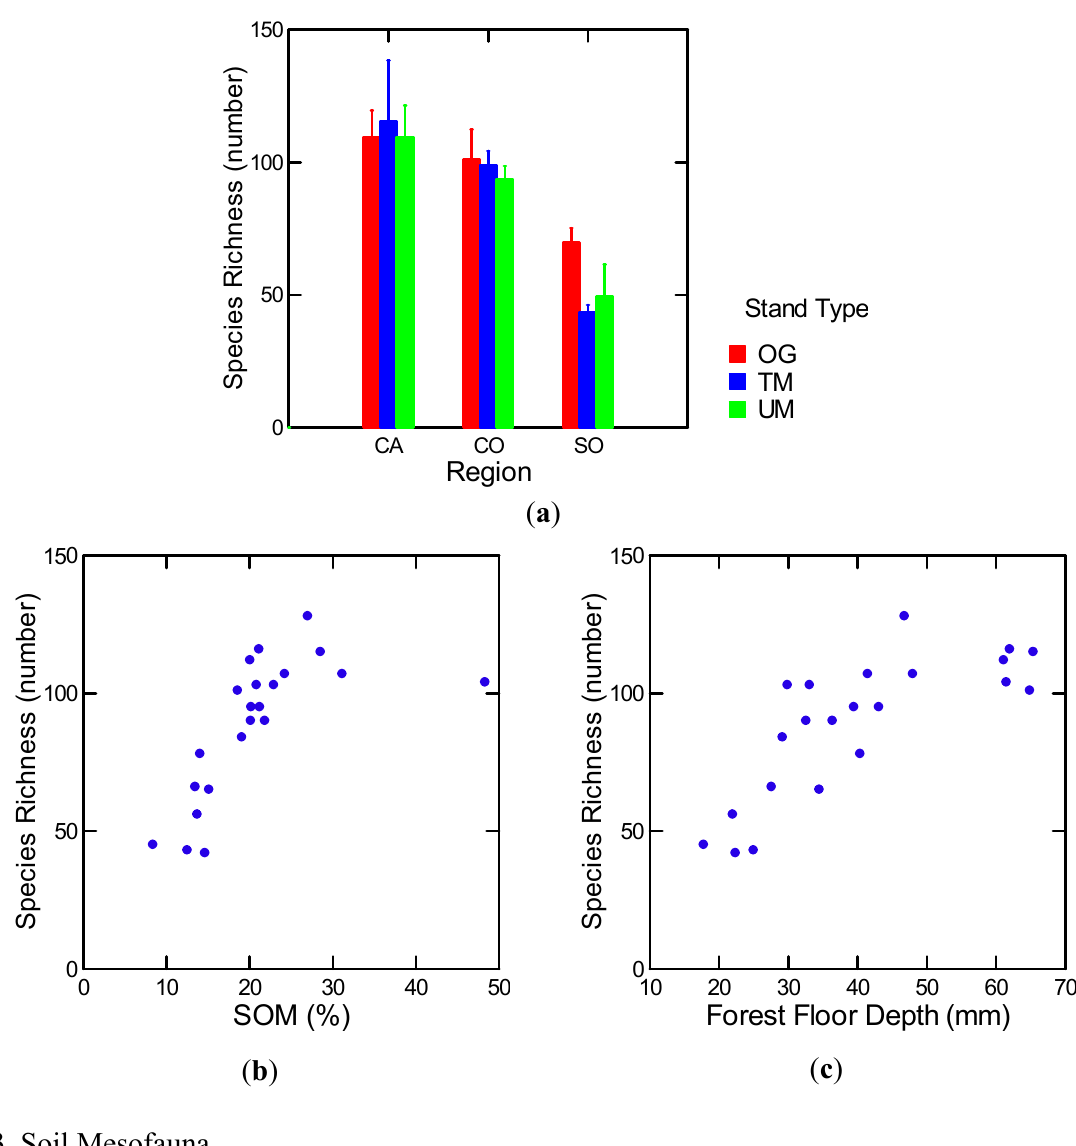
Figure 7. ( a ) Species richness of forest floor mesofauna. CA = Cascades; CO = Coast Range; SO = Siskiyous; Bars = standard errors. One site in the Cascades and one site in the Siskiyous are not represented (incomplete data); ( b ) Species richness of forest floor mesofauna as related to forest floor depth; ( c ) Species richness of forest floor mesofauna as related to percent soil organic